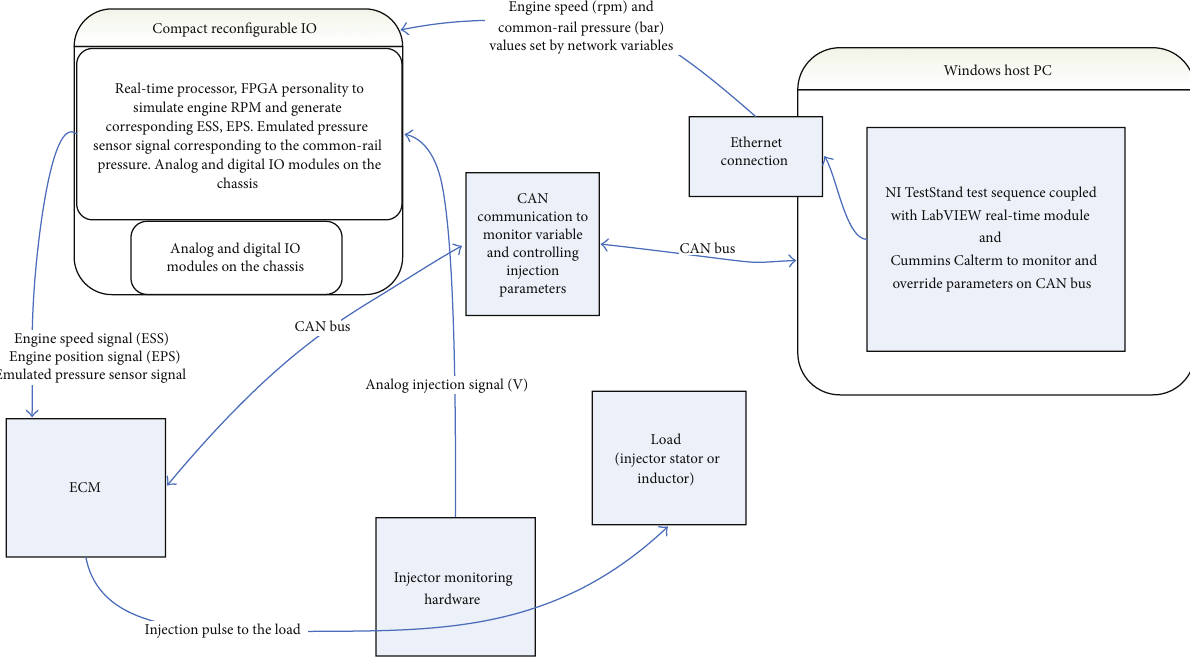
Figure 3: Layout of the bench for this research.